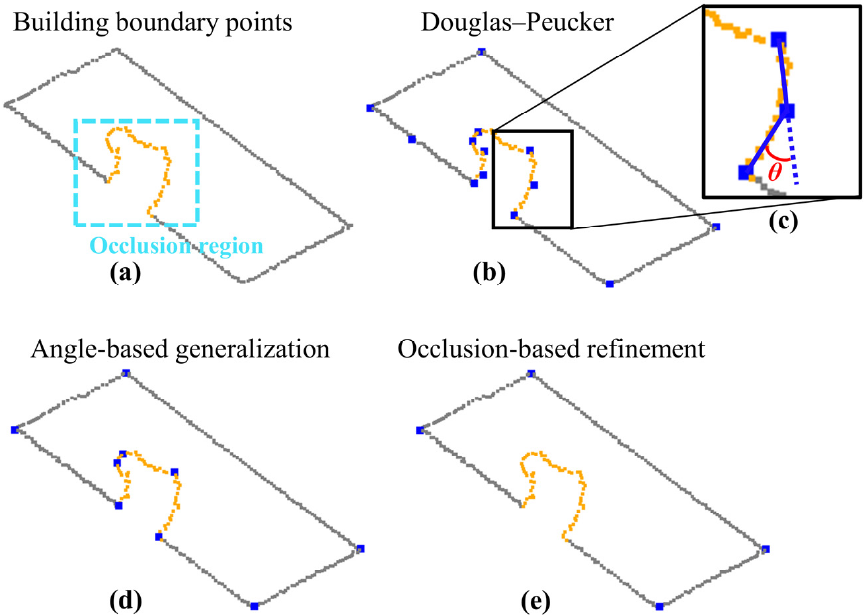
Figure 3. Critical point determination for a partially occluded building roof: Boundary points extracted using alpha-shape algorithm ( a ). Critical points derived from Douglas–Peucker (blue squares) ( b ). The angle θ between two adjacent lines formed by connecting adjacent critical points ( c ). Critical points derived from angle-based generalization ( d ), and from occlusion-based refinement ( e ).